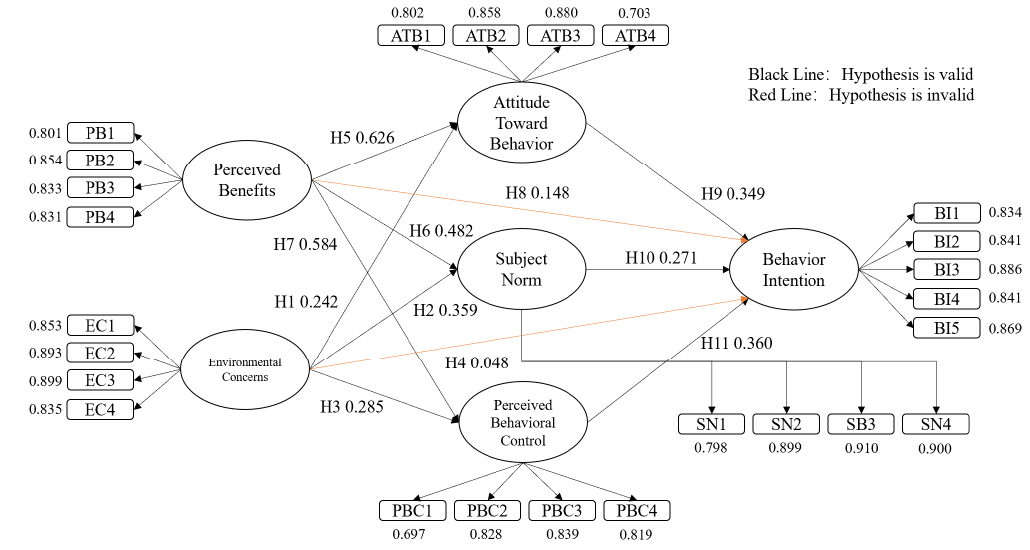
Figure 2. Research structure pattern diagram.